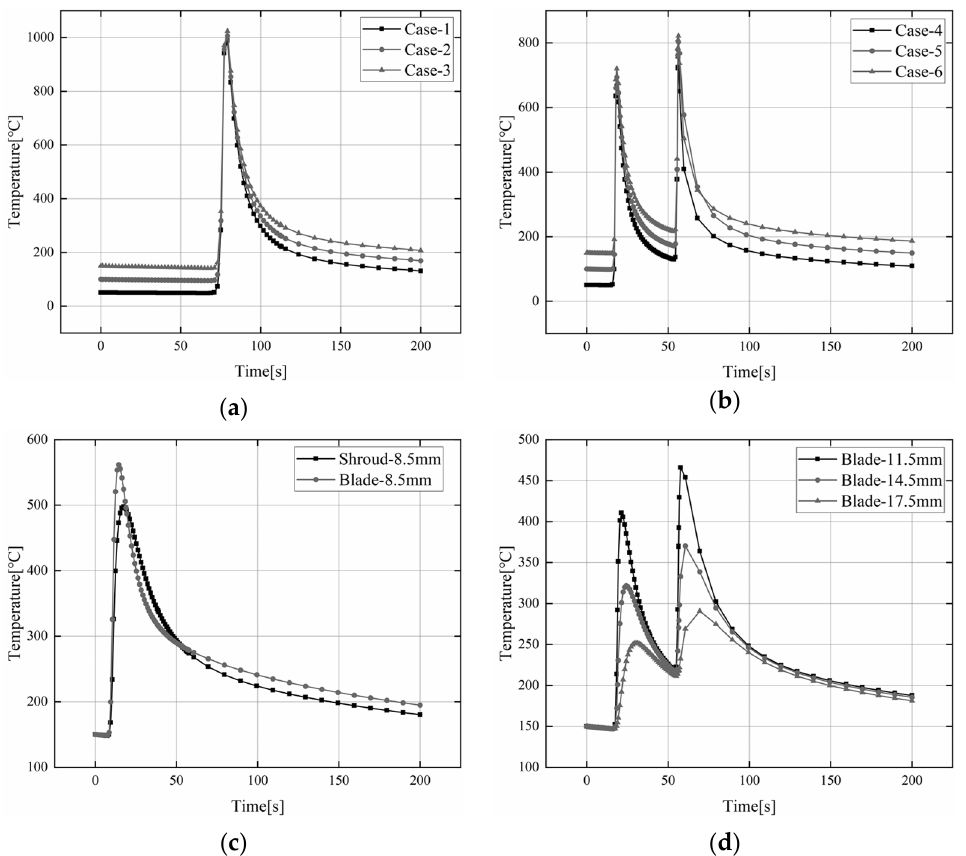
Figure 12. Transient temperature distribution. ( a ) Transient thermal cycling of Path A; ( b ) Transient thermal cycling of Path B; ( c ) Transient thermal cycle at the same distance from the center of the weld; ( d ) Transient thermal cycles at 11.5, 14.5 and 17.5 mm from the center of the weld.